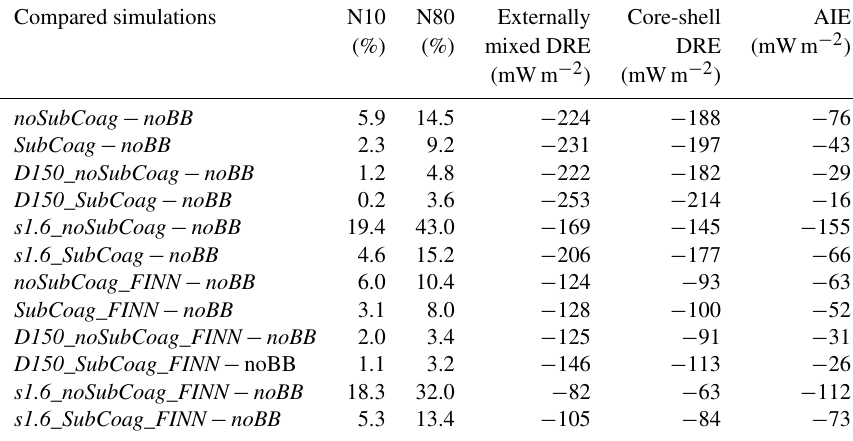
Table 2. Global, annual-mean percent change due to biomass burning in the surface-level N10 and N80 and absolute changes in DRE and AIE due to biomass burning. Compared simulations N10 N80 Externally Core-shell AIE (%) (%) mixed DRE DRE (mWm − 2 ) (mWm − 2 ) (mWm − 2 ) noSubCoag − noBB 5.9 SubCoag −